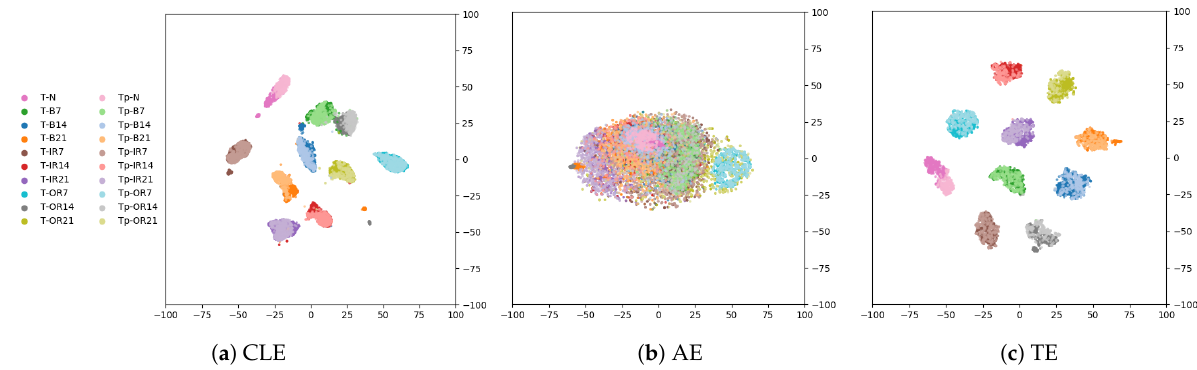
Figure 2. Case Study 1: t-SNE plot of feature space on T ∪ T p of the classifier encoder (CLE), the Autoencoder (AE), and the Triplet Encoder (TE). Table 4. Case Study 1: Classification and clustering results on various operating conditions based on feature spaces of the FFT, the Autoencoder based on the FFT (AE FFT ), the Autoencoder (AE), the Classifier Encoder (CLE), and Triplet Encoder (TE) models. (Bold indicates the best